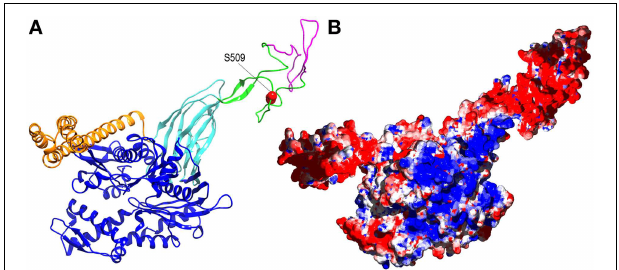
FIGURE 2 | Alternative splicing and phosphorylation of the acidic insertion loop may regulate Hsp110 activity. (A) Ribbon model of human Hsp110 based on the crystal structure of yeast Hsp110 (pbd 3C7N Schuermann et al., 2008) with nucleotide binding domain in blue, the β -sandwich and α -helical portions of the protein binding domain in, respectively, cyan and orange, and the acidic insertion loop in green with the element that is removed by alternative splicing in magenta and the phosphorylated S509 side-chain in red. (B) The same model as in A but in surface representation with positively and negatively charged regions in blue and red,